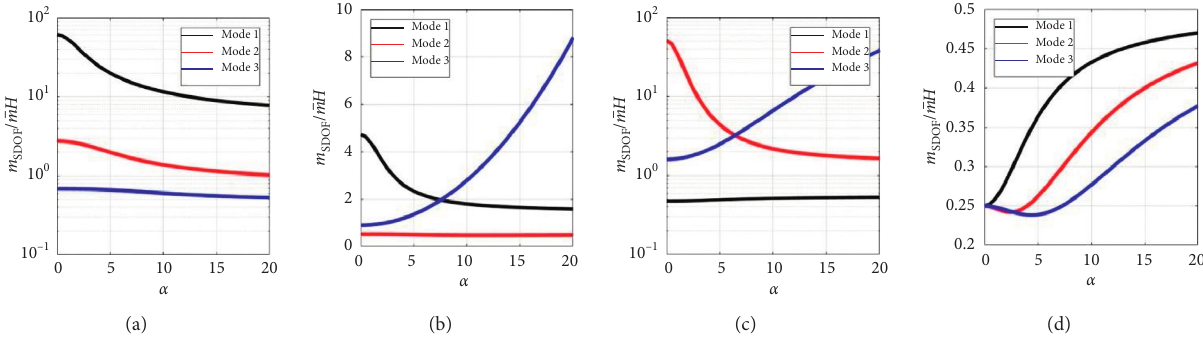
Figure 4: Structural mass of an equivalent SDOF system. (a) Z